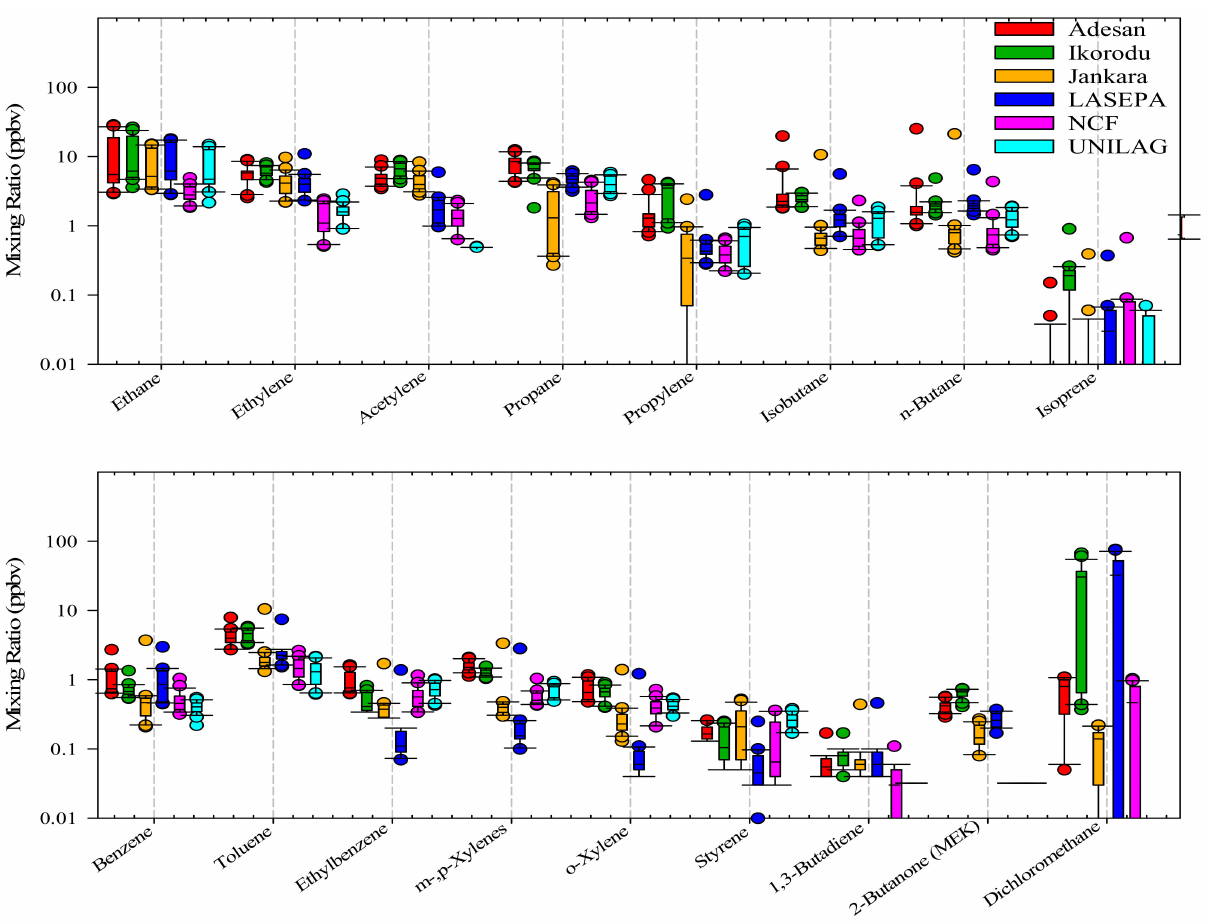
Figure 5. Box and whisker mixing ratio plots of canister sample analysis for VOC species between 2020 and